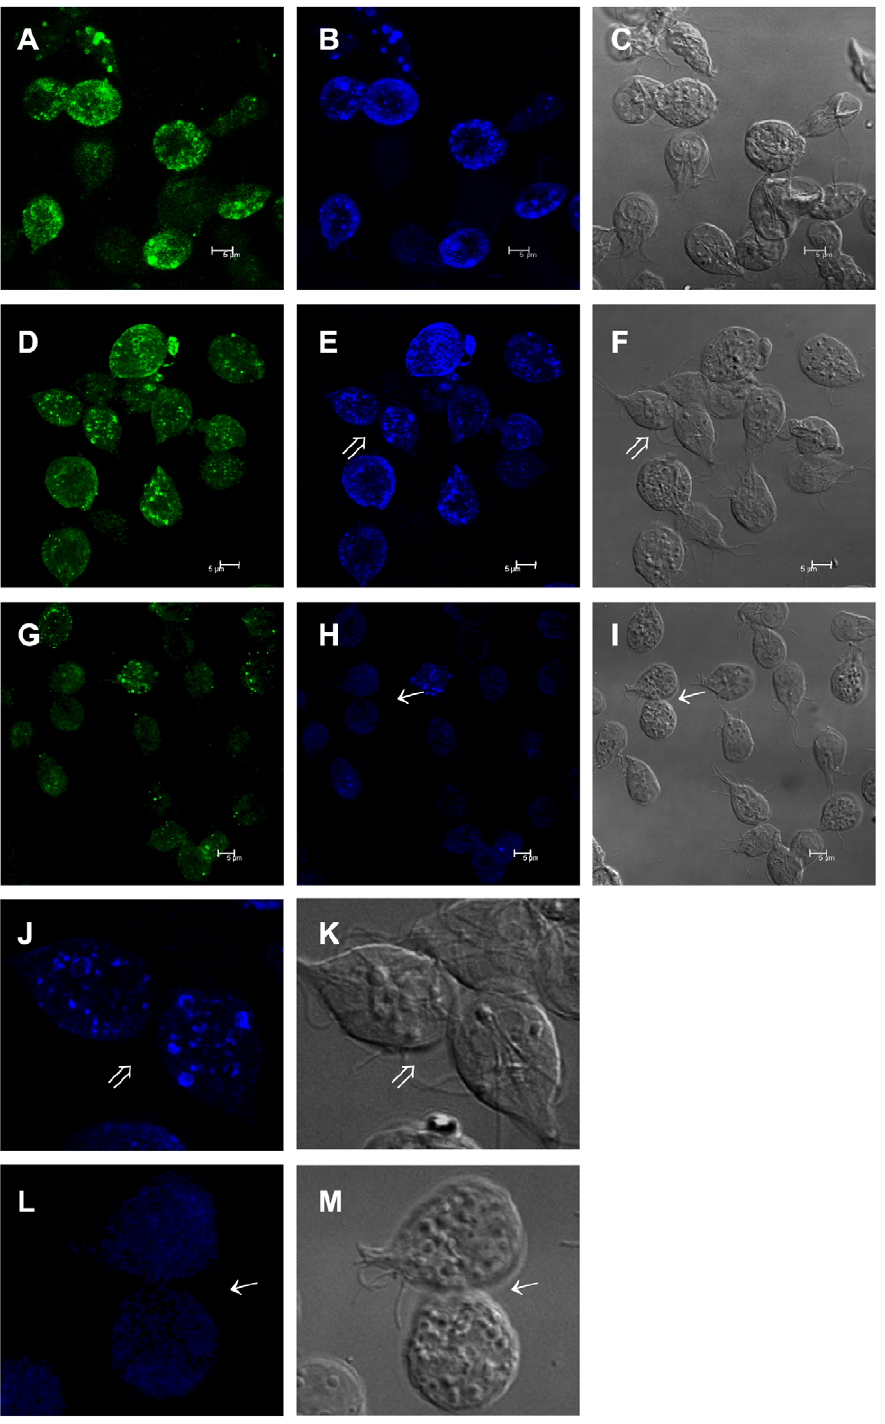
Figure 10. Rab11 ribozyme affected CWP1 localization during Giardia encystation. Samples of parasites transfected with pC631pac-Rab11B (GPRB) or pC631pac-Rab11M (GPRM) and cultured in the presence of 50 or 200 m g ml 2 1 of puromycin were induced to undergo encystation and processed for confocal microscopy. Rab11 was stained with the rat anti-Rab11 antibody and a FITC-conjugated goat-anti-rat secondary antibody ( A , D and G ). CWP1 was stained with the anti-CWP1 antibody and a Cy5-conjugated goat-anti mouse antibody ( B , E and H ). A–C show GPRM (50 m g ml 2 1 puromycin). D–F show GPRB (50 m g ml 2 1 puromycin). G–I show GPRB (200 m g ml 2 1 puromycin). J and L show magnified precyst. C, F, I, K and M are the DIC images. Arrows indicate magnified cells.